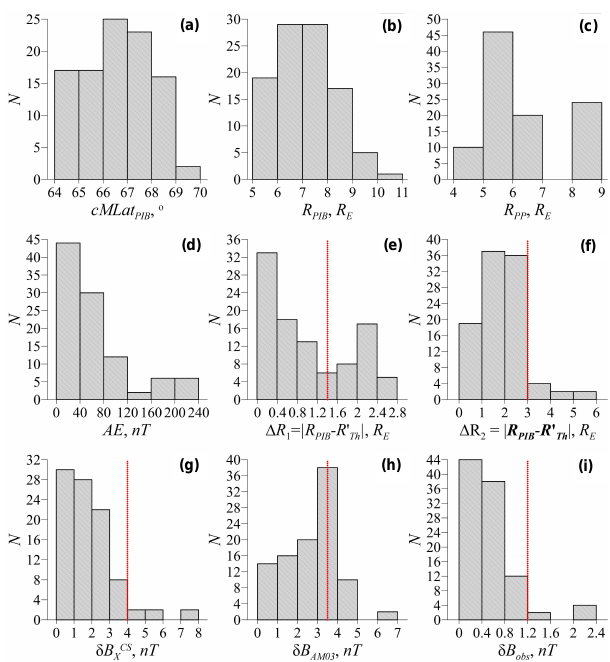
Figure 3. Parameter distributions characterizing our data set. (a) corrected magnetic latitudes (absolute values) of isotropy boundaries (30 and 80keV IBs are plotted together); (b) ra- dial distances of projected IBs; (c) plasmapause positions (along THEMIS trajectories); (d) AE index; (e–f) distances between PIB and THEMIS spacecraft closest to this point; (g–i) parameters used to characterize the model accuracy (see text for explanations). The red vertical lines show the maximal parameter value allowed for the subgroup of the most accurate models